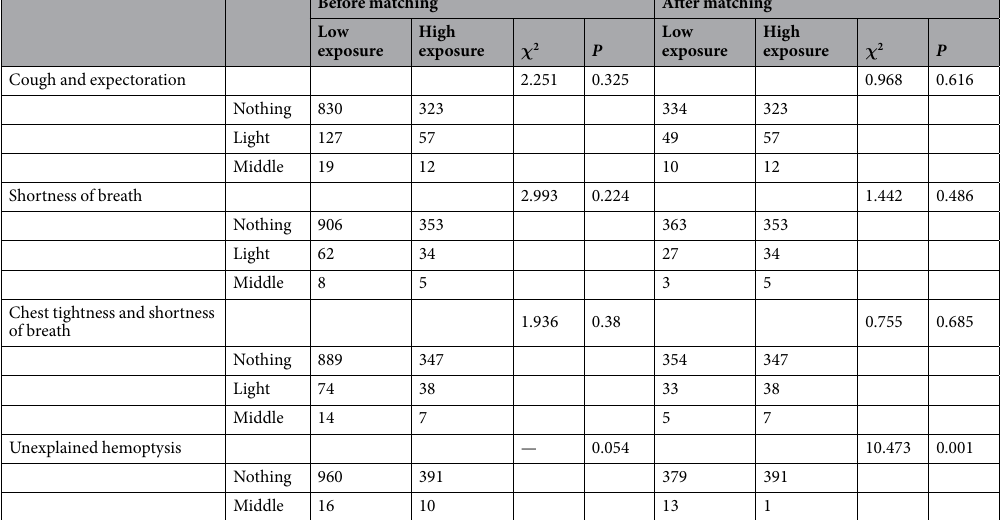
Table 9. Difference Test of Symptom Frequency in Respiratory system before and after Matching.